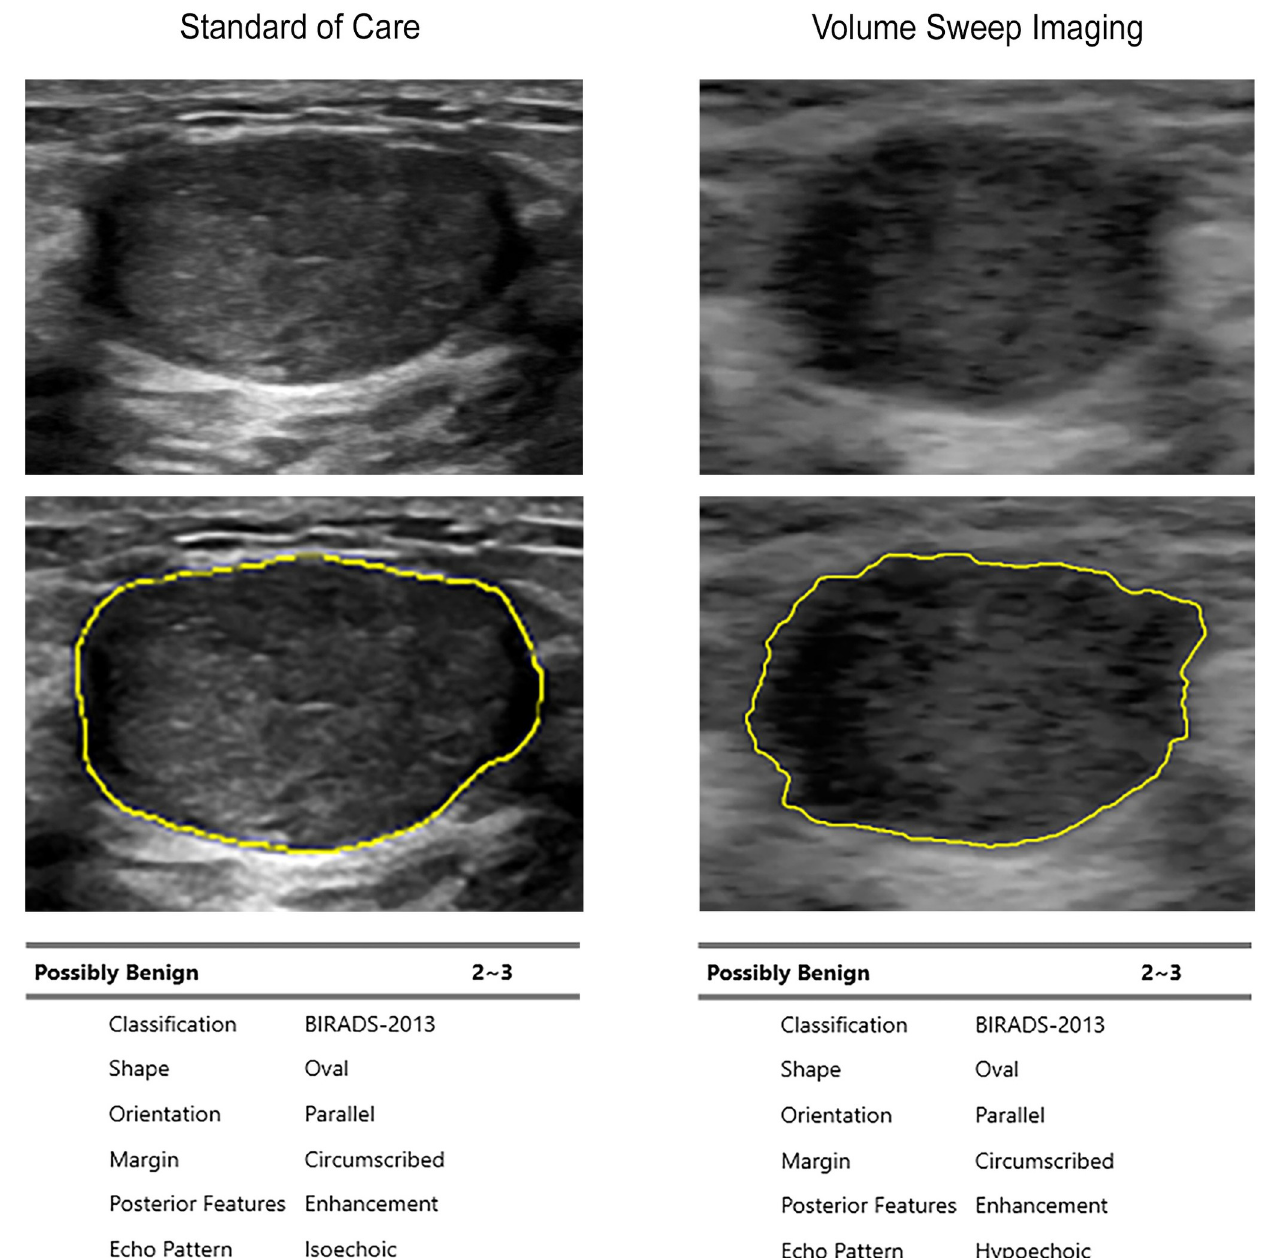
Fig 1. S-Detect Interpretation of a Fibroadenoma on Standard of Care and VSI. B-mode ultrasound images of a fibroadenoma are shown with their respective mass segmentations and S-Detect produced reports. The standard of care image was obtained by a certified expert breast sonographer using a General Electric Logiq E10 ultrasound machine. The VSI image was obtained by a medical student without prior medical experience after less than 2 hours of training on a portable Butterfly iQ ultrasound probe. S-Detect results between standard of care and VSI are identical apart from standard of care echogenicity reported as isoechoic (a trivial difference). The S-Detect results for VSI were identical to expert interpretation of standard of care and VSI. https://doi.org/10.1371/journal.pdig.0000148.g001 combined analysis of mass echogenicity. S1 Table shows the full analysis of mass characteris- tics agreement across different categories of masses. Among pathologically proven cancers (n = 20), S-Detect rated all as “probably malignant” on both standard of care imaging and VSI. Among pathologically proven fibroadenomas